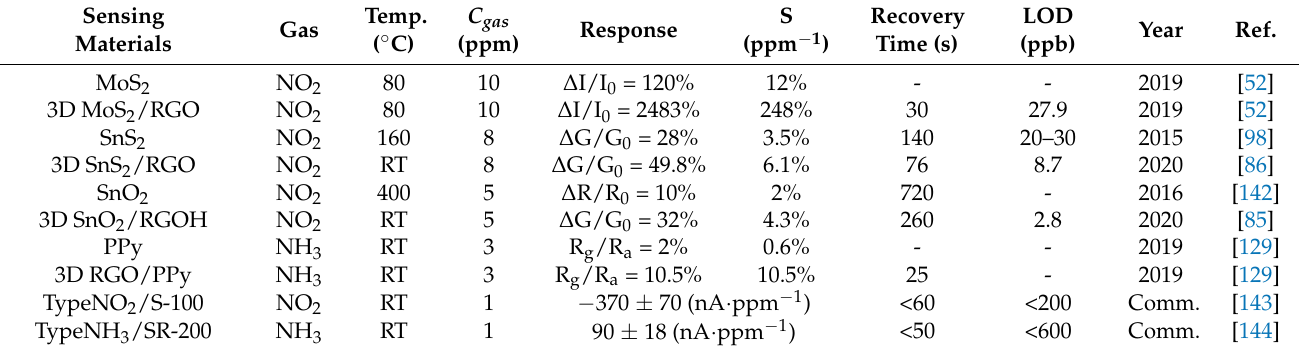
Table 2. Sensing performance comparison of 3D graphene and other semiconductor materials including commercial sensors.